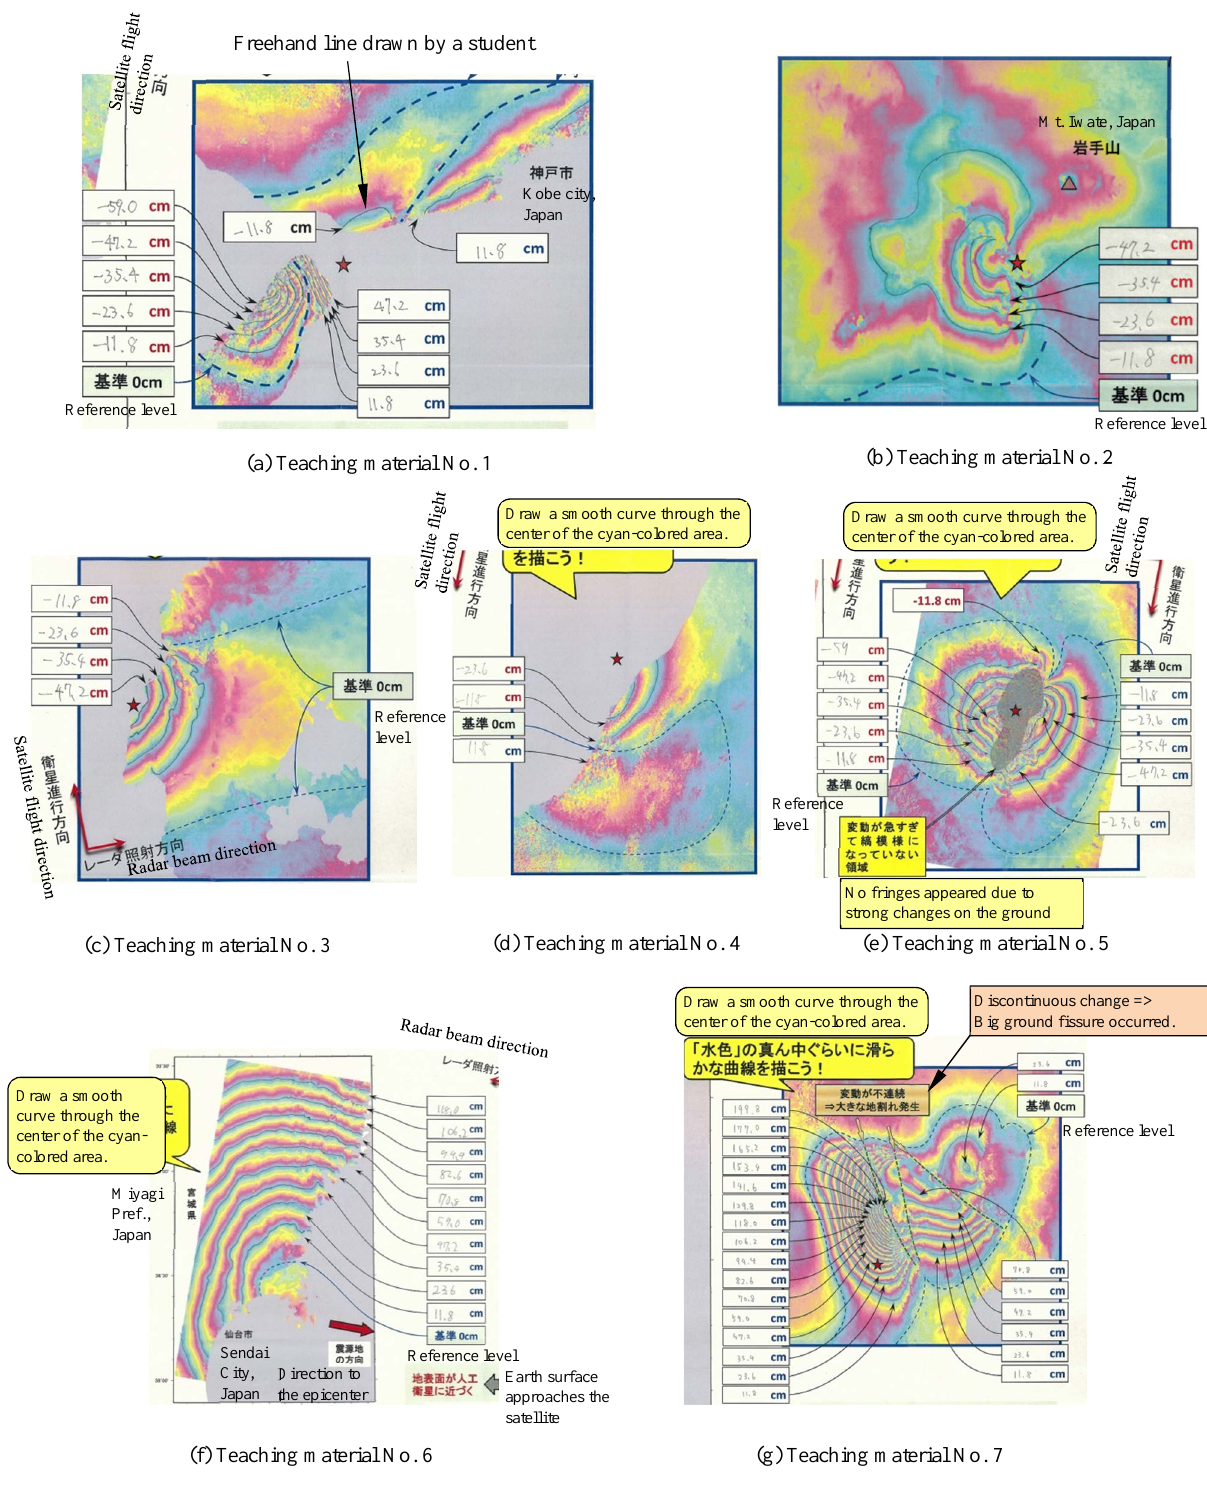
Figure 3. Finished worksheets with freehand lines and deformation values written by a student ; the red star indicates the epicenter, and the details of each of the teaching materials are listed in Table